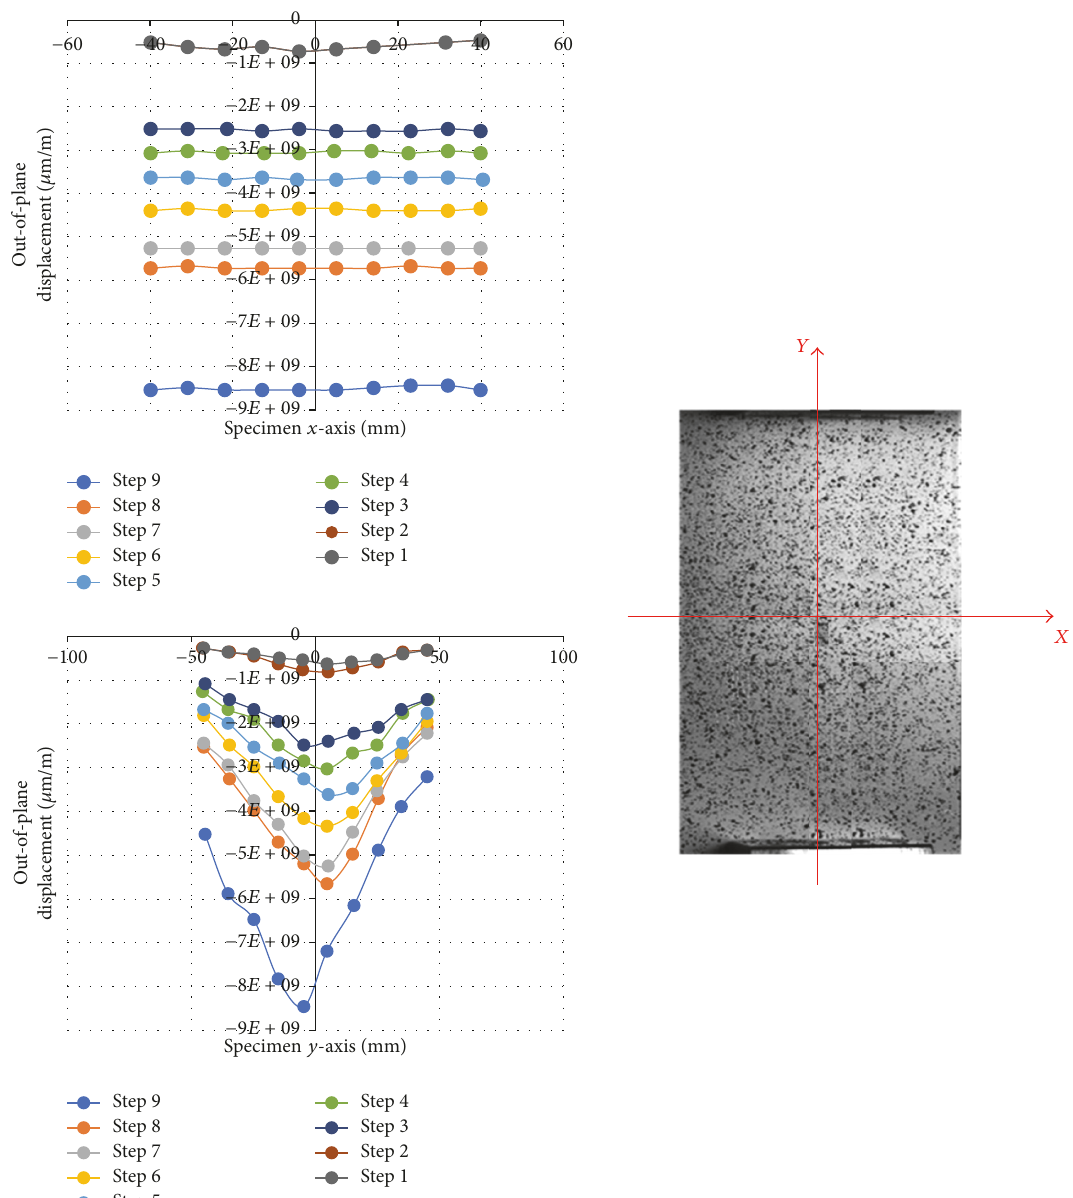
Figure 18: Out-of-plane displacement values along symmetry axes-central delamination